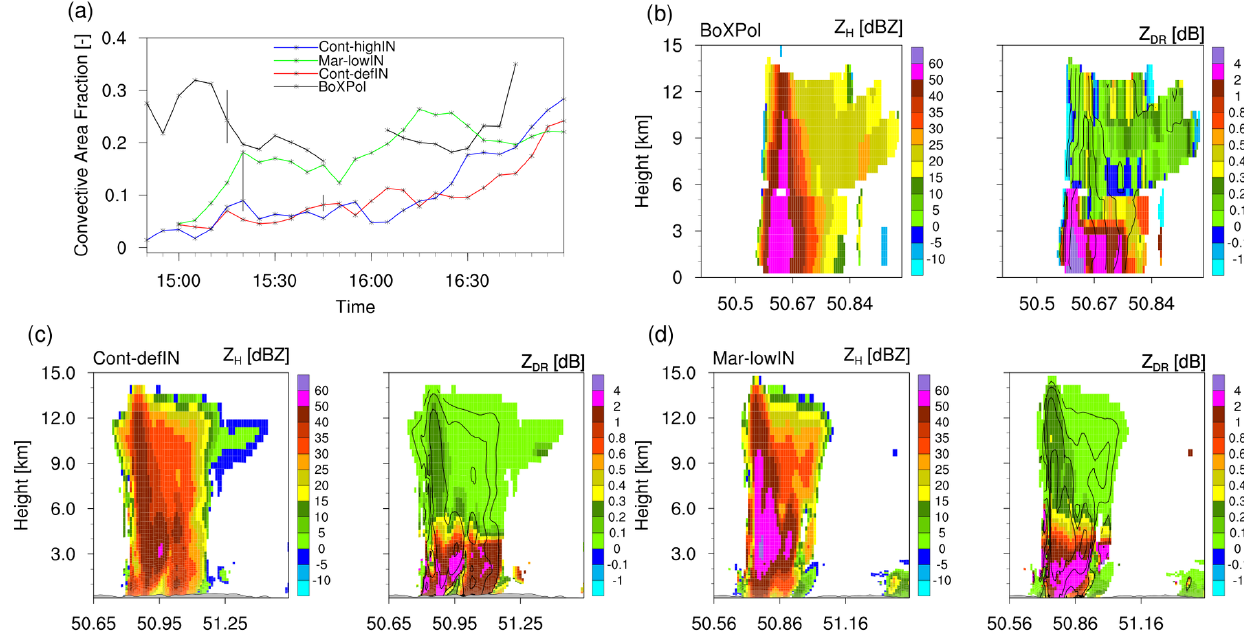
Figure 5. Time series of convective area fraction (CAF) evolution (a) and reconstructed observed (b) and simulated/synthetic range–height indicators (RHIs) of horizontal reflectivity Z H and differential reflectivity Z DR (c, d) . Synthetic RHIs are based on simulations for actual land cover with different perturbations of CN and IN concentrations, where Cont-defIN indicates continental aerosol with default IN concentration, and Mar-lowIN indicates maritime aerosol with low IN concentration. The gaps in the BoXPol-observed CAF time series are due to strong attenuation. The vertical grey bars (a) indicate the times at which the RHIs are compared.